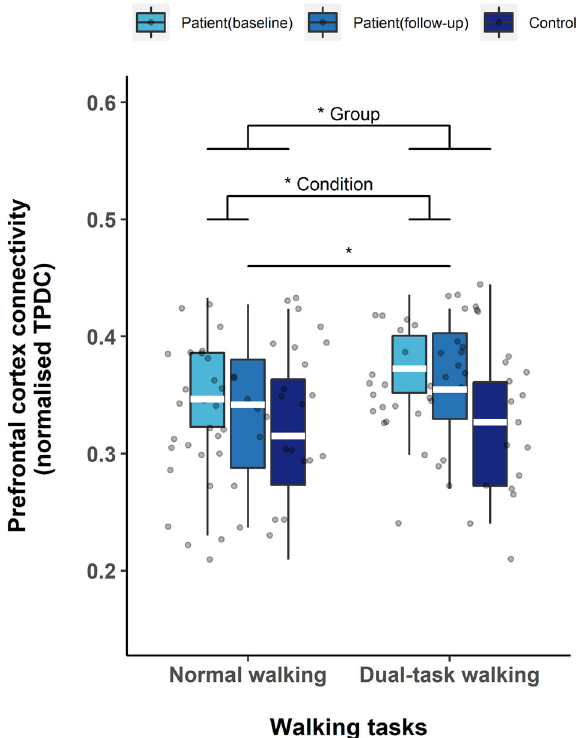
Fig. 2 Effective connectivity in prefrontal cortex during walking tasks. Effective connectivity value in prefrontal cortex (vertical axis) during normal walking and dual-task walking conditions (horizontal axis). The box represents lower quartile, median and upper quartile. Non-parametric two-way ANOVA indicated signi fi cant main effect for training (between patients and controls at baseline) and condition (between NW and DT). Wilcoxon signed-rank test indicated signi fi cant difference between NW and DT walking in patients at follow-up. ∗ p < 0.05; white line (within the box): median level. signi fi cant lower prefrontal connectivity during NW compared with DT ( p = 0.018).